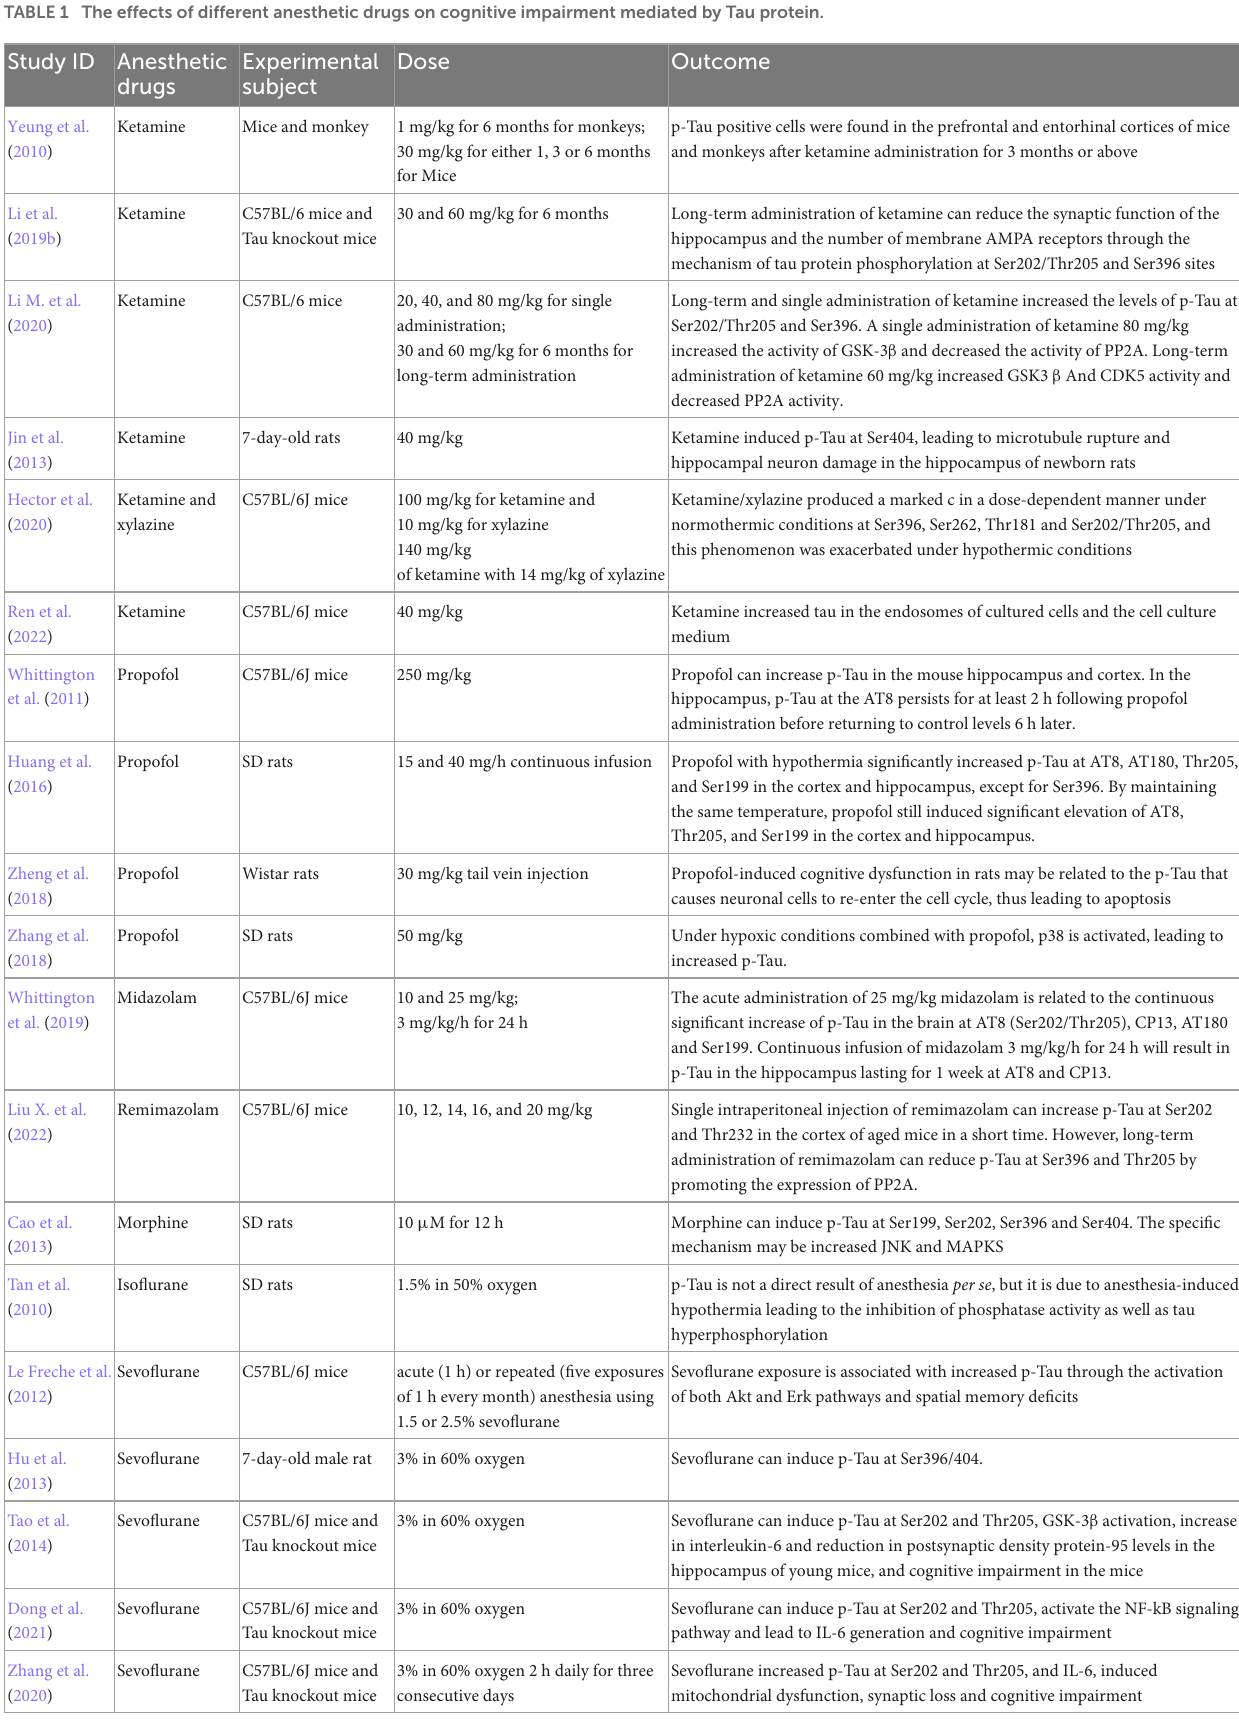
TABLE 1 The effects of different anesthetic drugs on cognitive impairment mediated by Tau protein. Study ID Anesthetic Experimental drugs